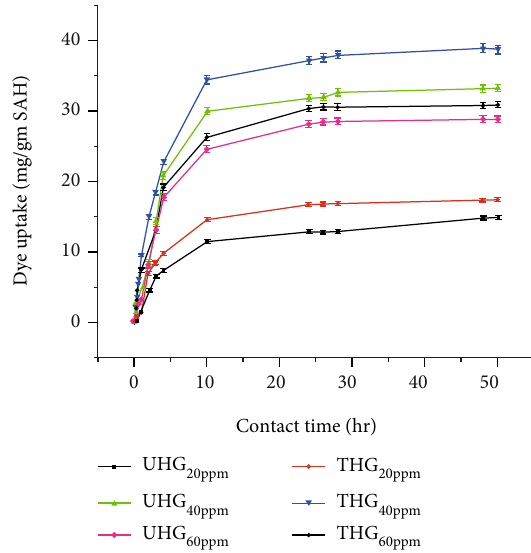
Figure 10: The e ff ect of contact time on the removal of methylene blue dye. Table 2: Characteristics/e ffi ciency value of SAH at 5.0kGy.